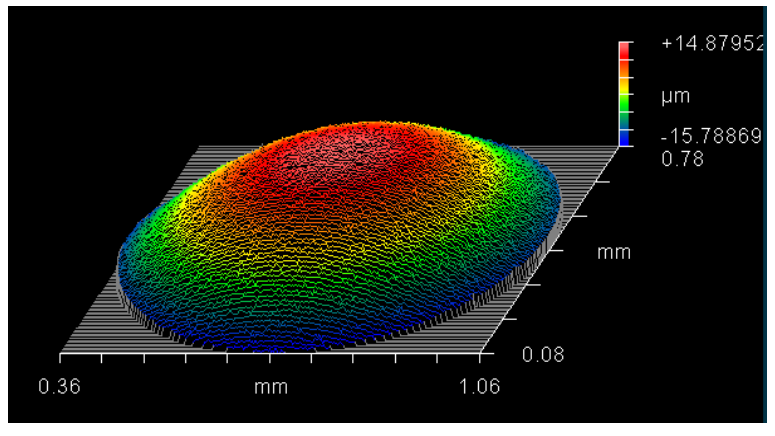
Figure 5. Three-dimensional profile of the 0.7-mm PDMS microlenses. The profile is taken using a ZYGO white light interferometer. The curvature is uniform across the surface of the microlens.